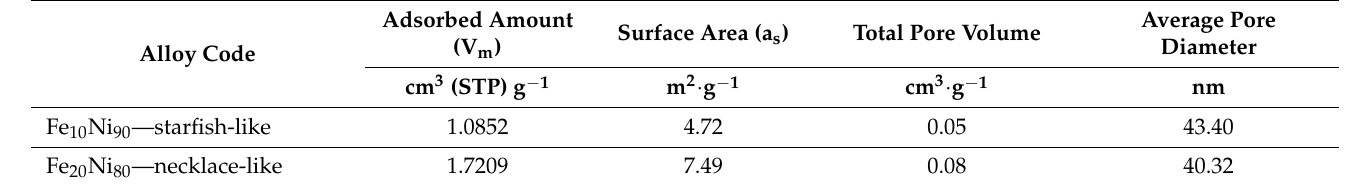
Table 2. The monolayer adsorption amount (V m ), adsorbate surface area (as), total pore volume, and average pore diameter of the prepared iron–nickel alloys used in this